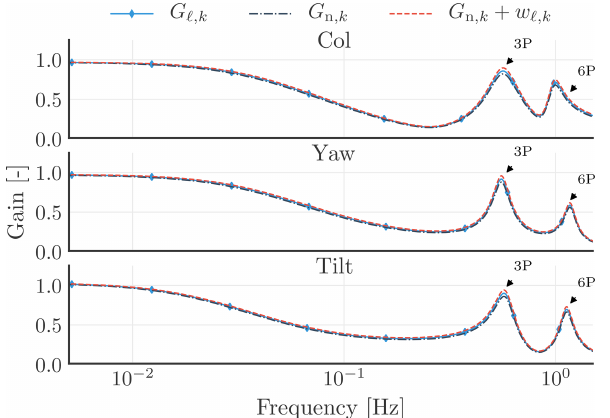
Figure 14. The identified disturbance measurement transfer func- tions ( G (cid:96),k ( j ω )). The dashed–dotted lines indicate the estimated nominal disturbance measurement models ( G n ,k ( jω )). The dashed lines show the sum of the estimated nominal disturbance mea- surement models and uncertainty weights ( G n ,k ( jω ) + w (cid:96),k ( j ω )), where k ∈ { col, yaw, tilt }